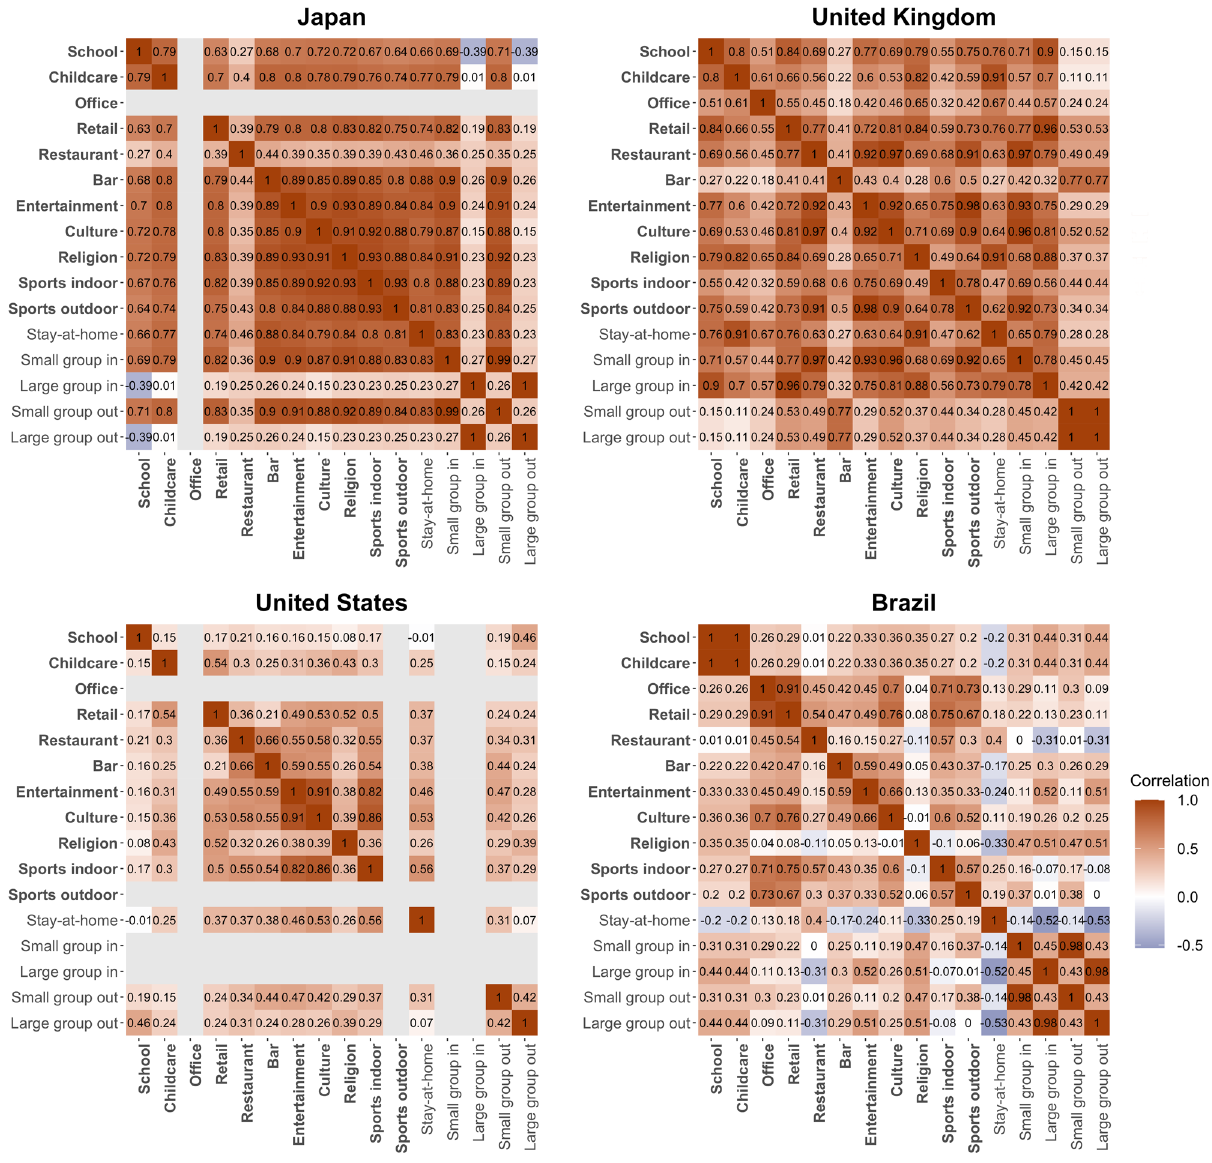
Fig. 1 Correlation between the status of establishments and other government interventions. The matrices show pairwise Kendall ’ s correlation coef fi cients between the status of establishments and other government interventions across the spatial units in each country during the study period. Bold texts indicate the establishments and regular texts are the other government interventions that we control for. Gray lines indicate that information on the corresponding intervention is missing in the country. The correlation coef fi cients are estimated based on samples excluding unit-day observations where the coef fi cient of variance for R t estimate is larger than 0.3 (suggesting unreliable estimates), which are 2400 in Japan, 24,285 in the United Kingdom, 41,752 in the United States, and 34,812 in